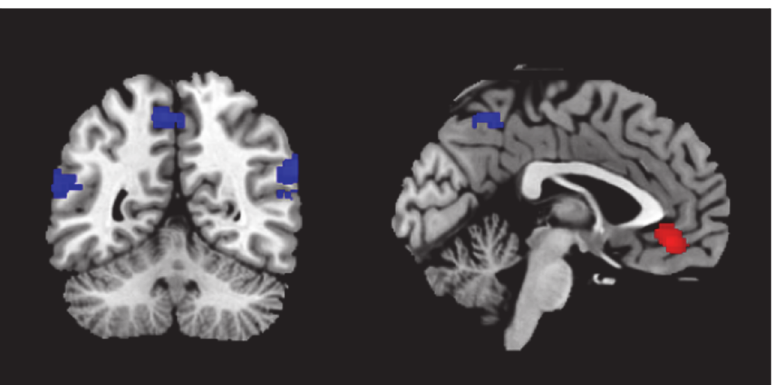
Fig 3. Brain maps illustrating activation clusters for the Mentalizing regressor contrasted against the Action regressor (red) and the Action regressor contrasted against the Mentalizing regressor (blue). All activations are corrected for the multiple comparisons at p <